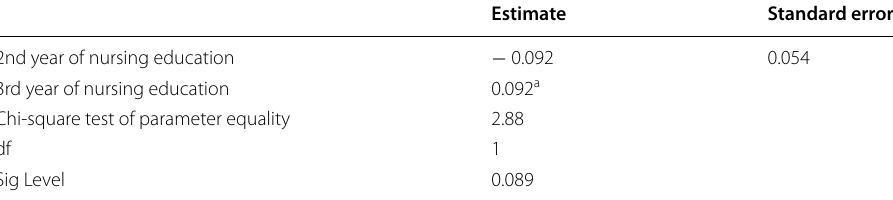
Table 8 Global DIF analysis to identify subgroup invariance between years of nursing